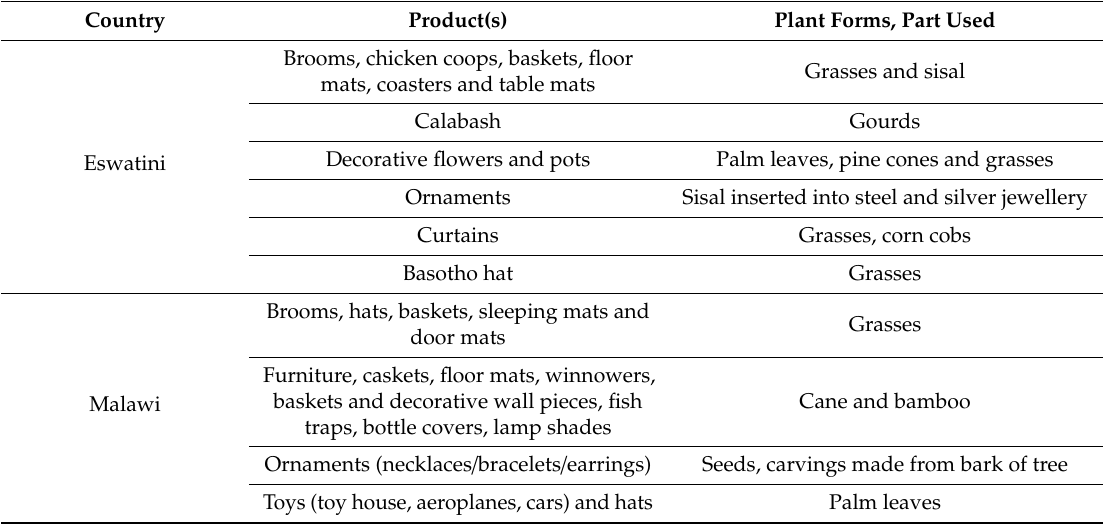
Figure 2. Photos of plant fibre products: ( A ) bamboo baskets; calabash from pumpkin and brooms and chicken poops in Eswatini, ( B ) cane furniture; floor mats and baskets and palm fibre toys in Malawi and ( C ) baobab fibre mats; and palm and bamboo baskets in Zimbabwe. (Photo credits: Deepa Pullanikkatil ( A , B ) and Gladman Thondhlana ( C ). Table 3. Plant fibre crafts produced and plants used in the three countries. Country Product(s) Plant Forms, Part